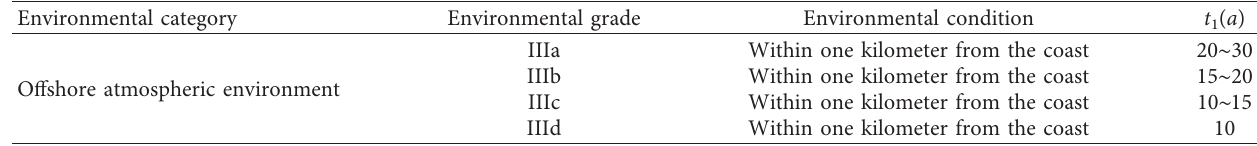
Table 4: Environmental grade and parameters of chloride erosion.